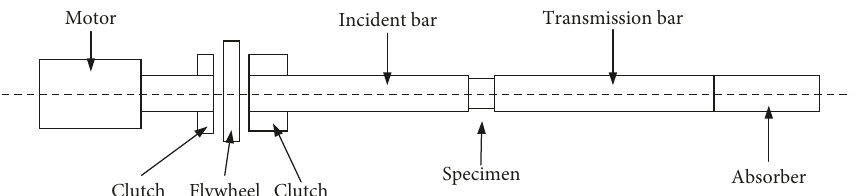
Figure 9: Sketch of the flywheel loading TSHB [42].